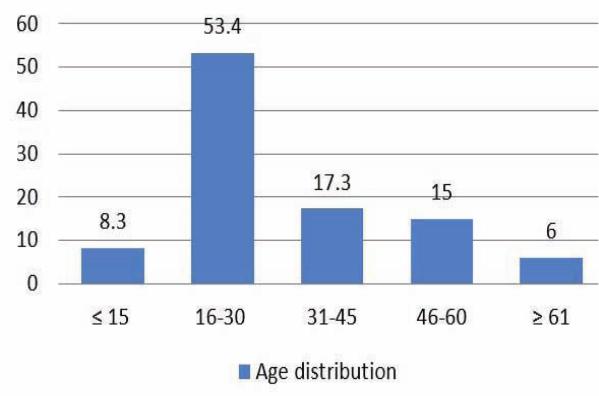
Figure 2: age distribution Geographical